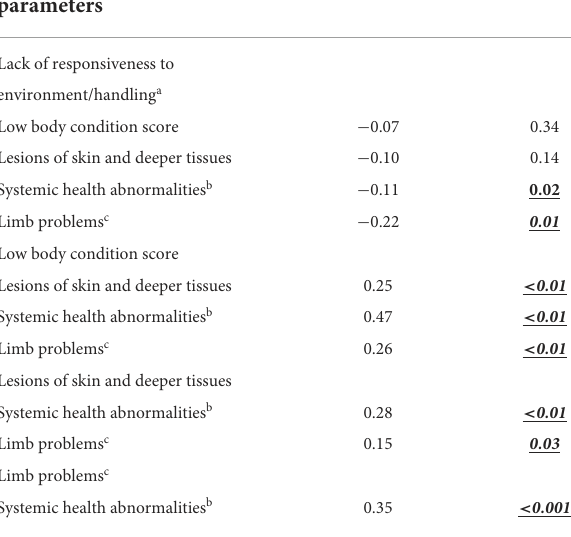
TABLE 4 Correlations between aggregated behavior and health parameters of working horses and mules ( n = 200). Behavior and